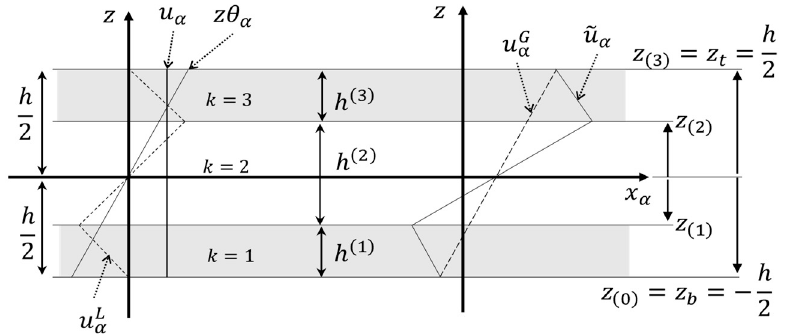
Figure 2. Contributions to the in plane refined zigzag theory (RZT) kinematics for a three-layered laminate.